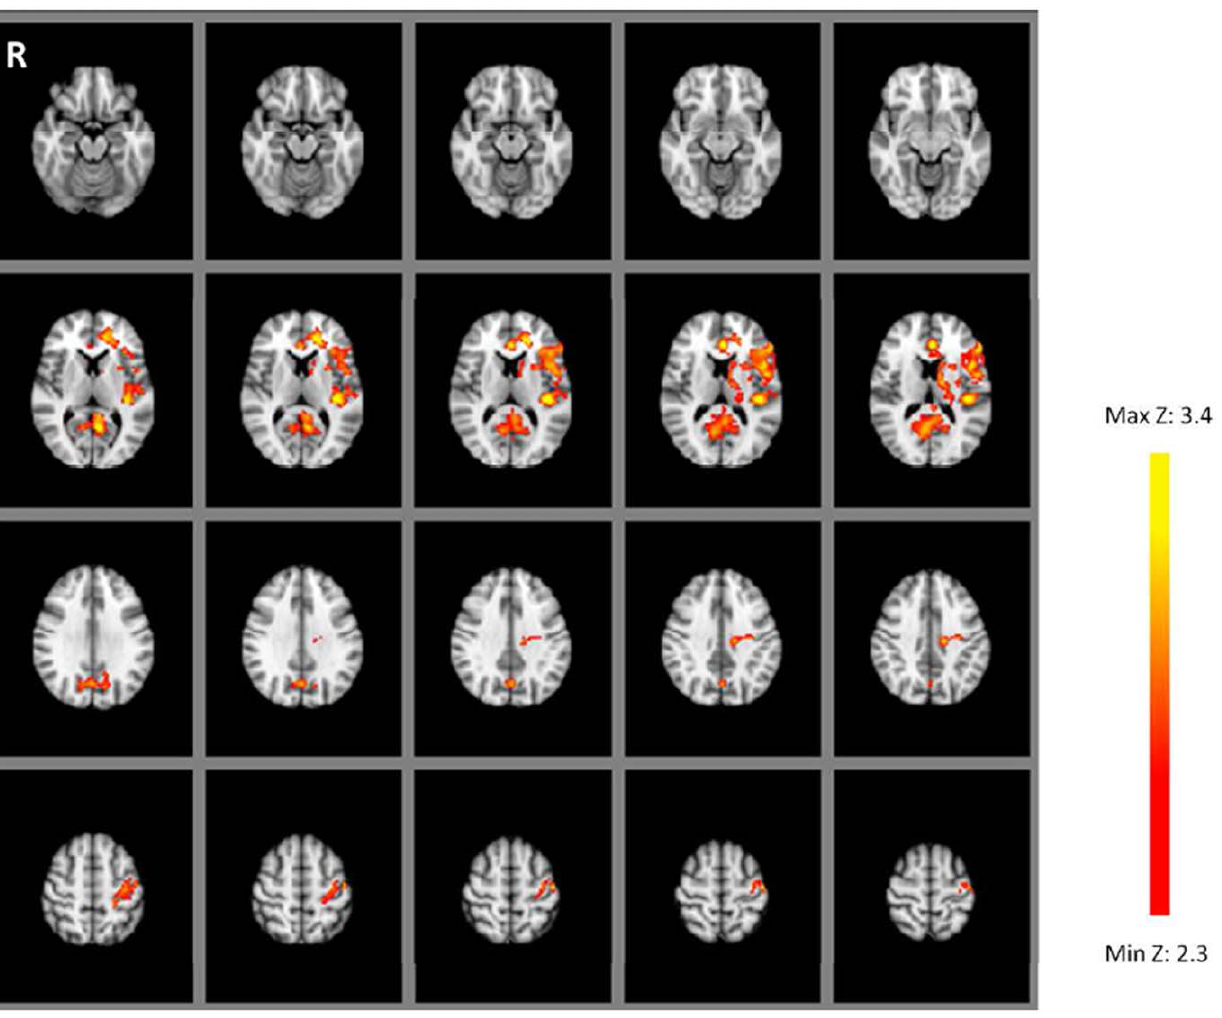
Figure 2. Data from Experiment 1. Percentage signal change in paired repeats relative to the unpaired baseline. Regions showing repetition suppression in both WM and Primed conditions. Voxelwise threshold: Z=2.3, p , .05, corrected for multiple comparisons. Images are in radiological orientation (right=left). doi:10.1371/journal.pone.0040870.g002 recognition test did not predict BOLD response during the Primed repetition blocks (F= .465, p= .638). Experiment 2: Influence of Pre-exposure of Stimuli Working memory task. Mean accuracy in the study phase WM task was 89% with a standard deviation of 10%.